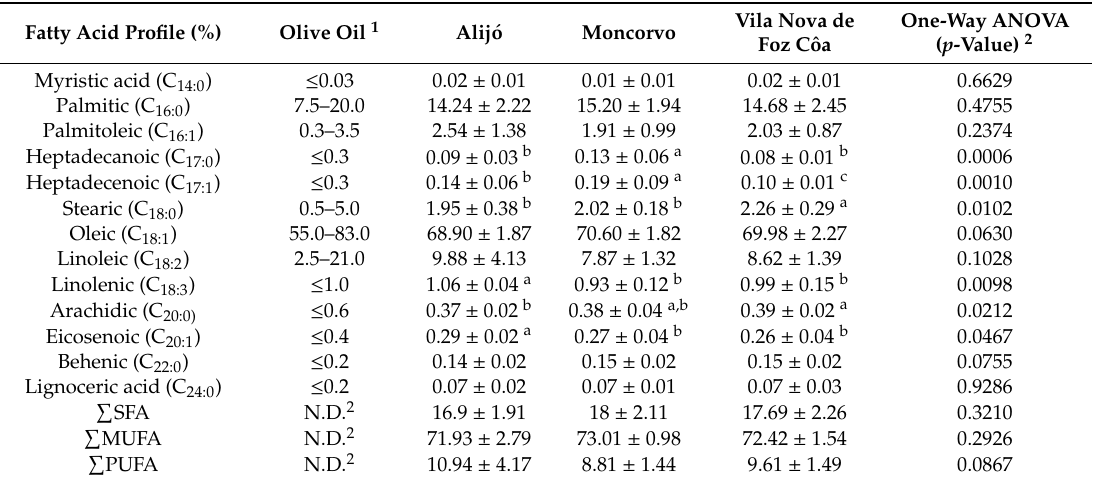
Table 2. Fatty acids profile (%) of oils extracted from oleaster (mean ± standard deviation) collected from di ff erent geographical locations (Alij ó , Moncorvo and Vila Nova de Foz C ô a).